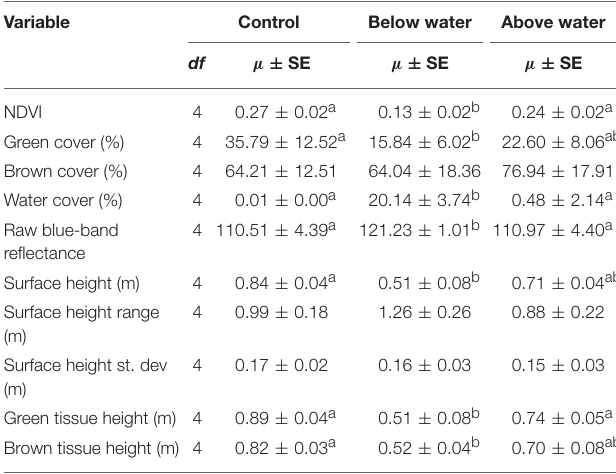
TABLE 6 | Comparison of UAV derived variable values by treatment (with Typha stand as a source of random effects) and Tukey post-hoc tests ( P <